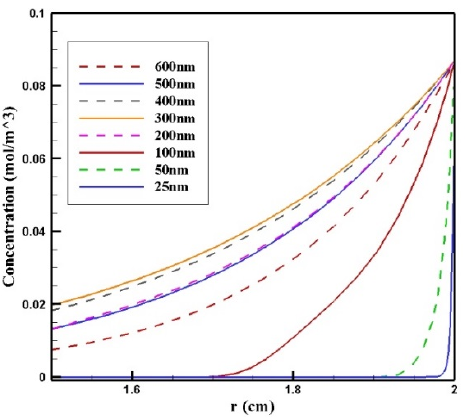
Figure 14. Comparison of the mean concentration of free drug ( C F ) along the diameter of the tumor in the area with the maximum penetration depth after 60 min of treatment for different sizes of MNPs. Table 6. Comparison of treatment efficacy parameters for different sizes of MNPs after 60 min of treatment.